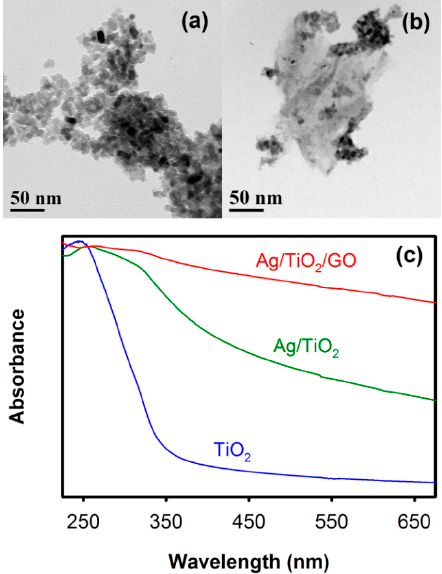
Figure 3. TEM micrographs of ( a ) Ag/TiO 2 and ( b ) Ag/TiO 2 /GO samples. ( c ) UV/visible optical absorption spectra of TiO 2 , Ag/TiO 2 , and Ag/TiO 2 /GO samples in water (concentration: 0.1 g/L).